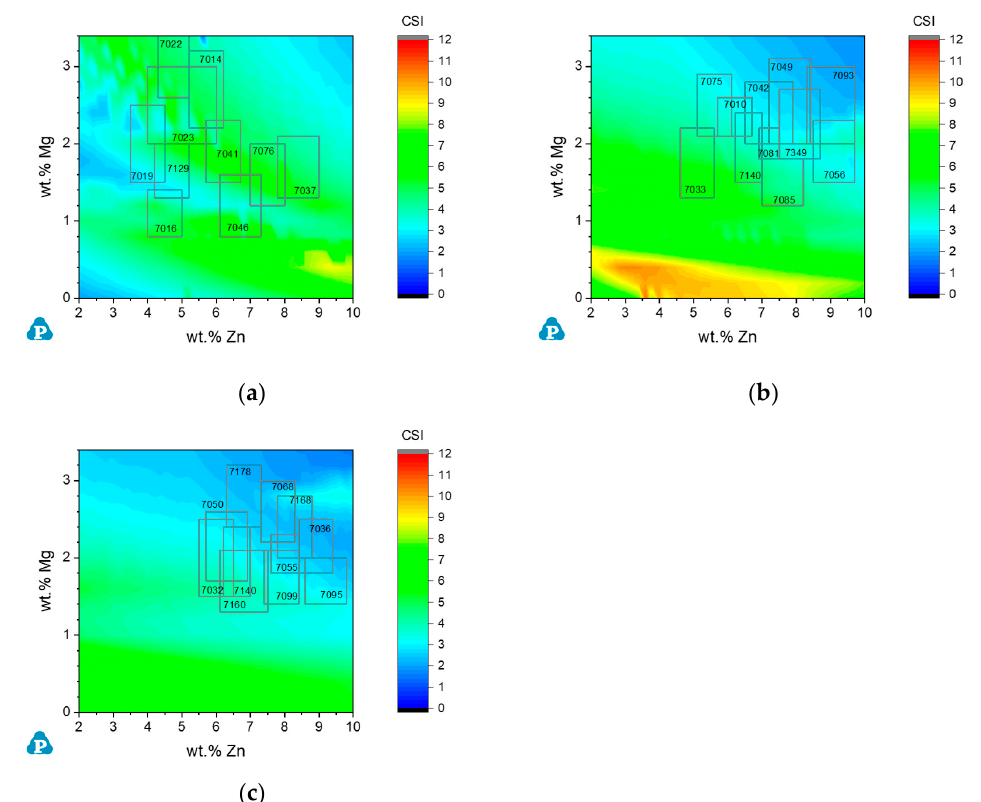
Figure 8. Calculated cracking susceptibility index ( CSI ) maps for AA7xxx alloys: ( a ) Al-0.2Si-0.3Fe-0.2Mn- 0.5Cu -xZn-yMg; ( b ) Al-0.2Si-0.3Fe-0.2Mn- 1.5Cu -xZn-yMg; ( c ) Al-0.2Si-0.3Fe-0.2Mn- 2.2Cu -xZn-yMg. Simulation is performed by improved Scheil model considering back diffusion in the solid under the cooling rate of 20 °C/s.